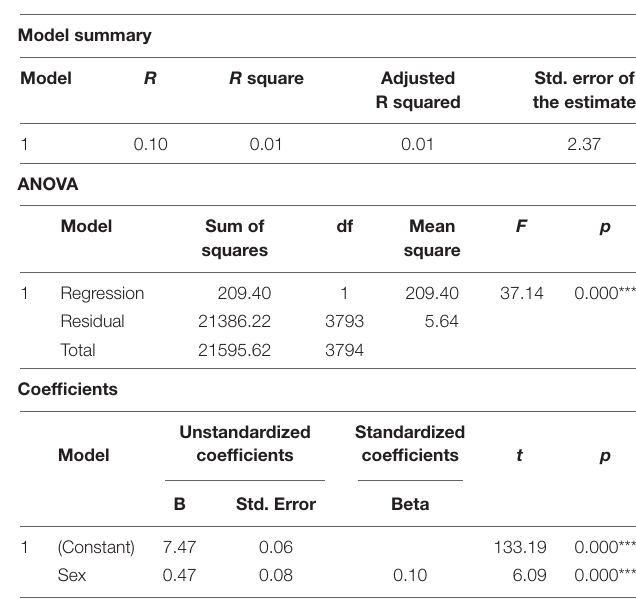
TABLE 8 | Regression analysis between sex and interest and motivation toward